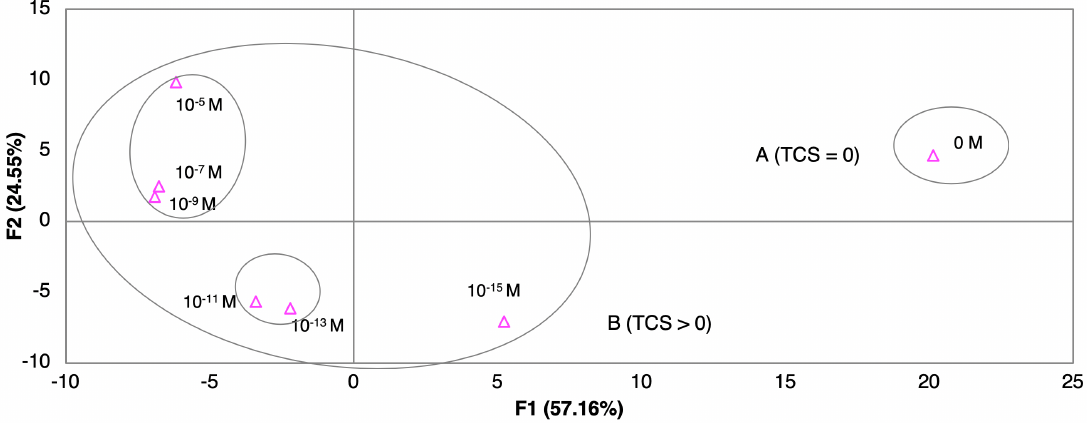
Figure 5. Principal components analysis (PCA) plot of TCS concentrations (10 −5 –10 −15 M) distinguished with an electronic tongue sensor for